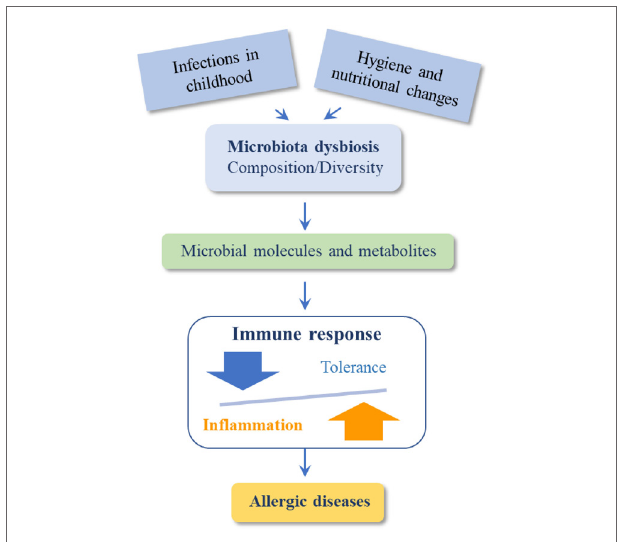
FiGURe 2 | Dysbiosis induce qualitative and quantitative changes in the microbiota that directly affect immunological mechanisms leading to allergic